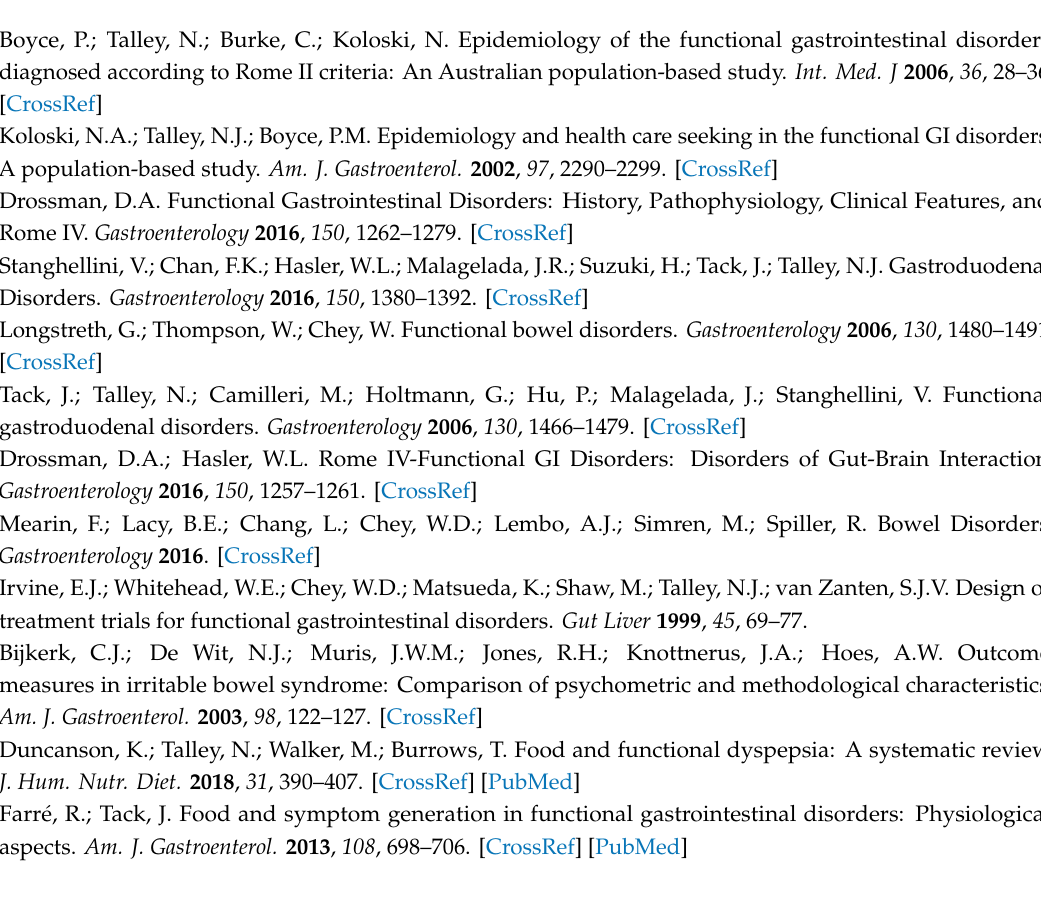
Table S1: Systematic review protocol of dietary factors that influence functional dyspepsia, Table S2: Participants, interventions, comparisons, outcomes and study design (PICOS) used to systematically review relationship between food ingestion and symptom reporting in functional gastrointestinal disorders, Table S3: PRISMA checklist for systematic review of the alignment of dietary intake and symptom-reporting capture periods in studies assessing associations between food and functional gastrointestinal disorder